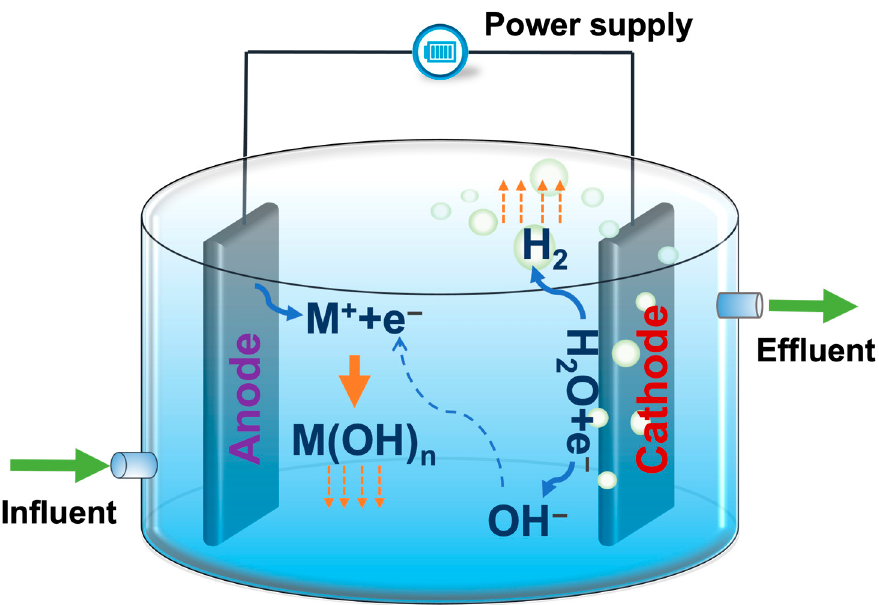
Figure 1. Schematic diagram of the electrocoagulation process.